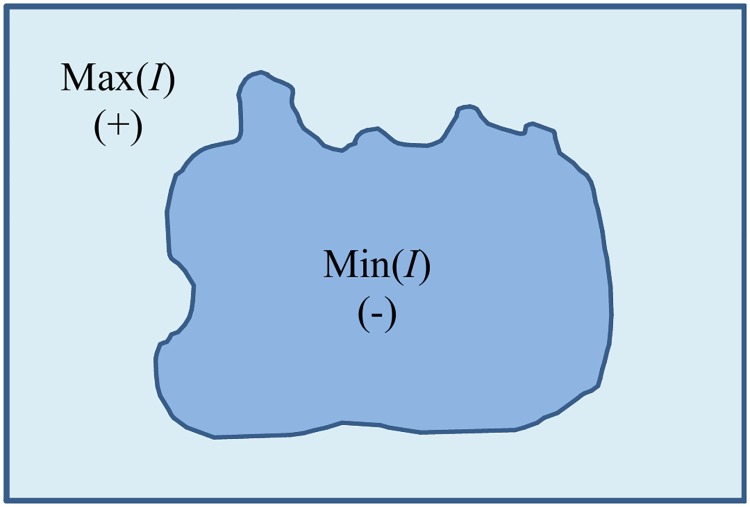
Signs of a global SPF function.It is positive outside the object and negative within it.